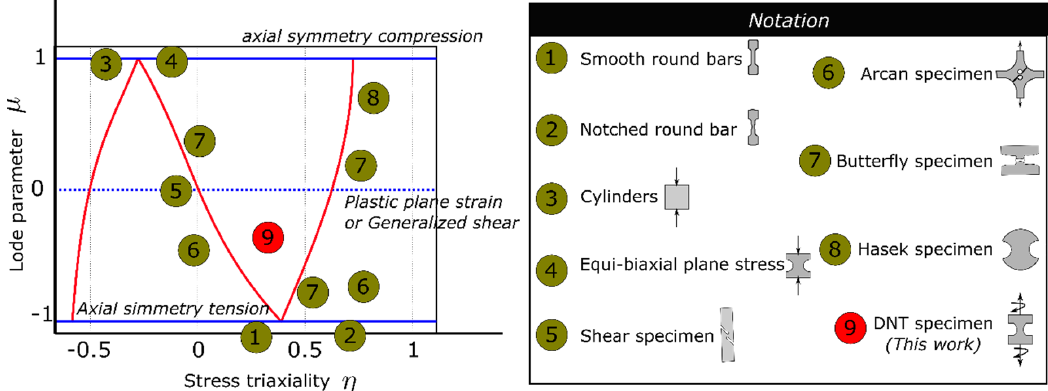
Figure 1. Conceptual representation of the stress states on the plane of stress triaxiality and Lode parameter.